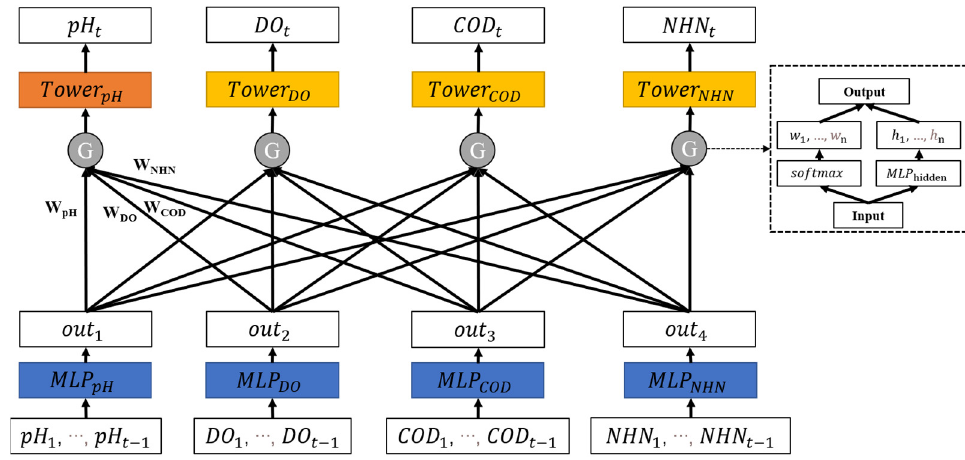
Figure 4. Gating parameter sharing structure of multi-indicator water quality prediction.